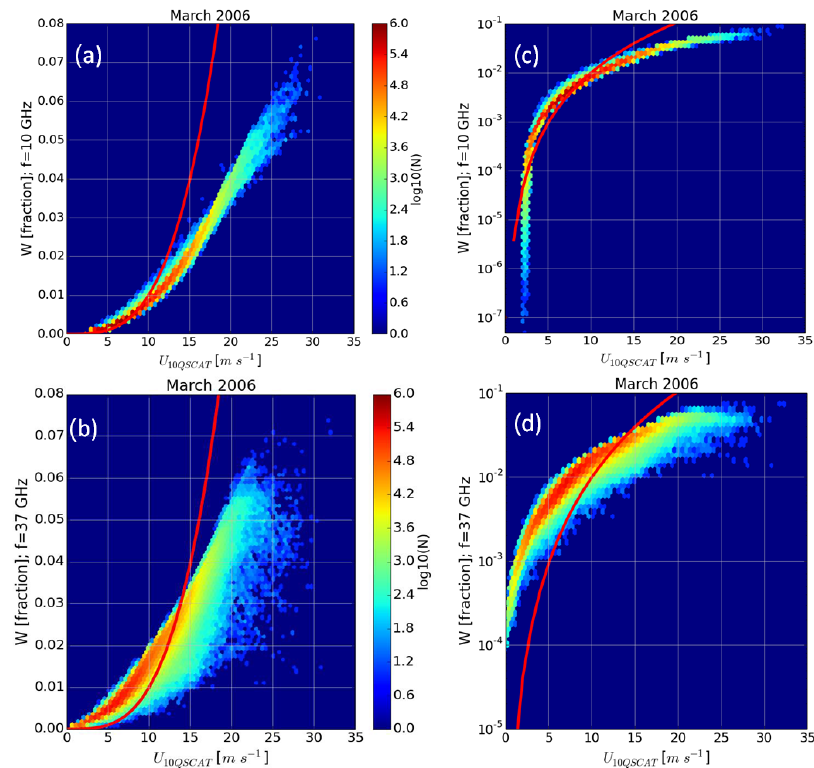
Figure 5. Global W as a function of U 10 from QuikSCAT for March 2006 where W is obtained with 10GHz (a) and 37GHz (b) mea- surement frequency. Panels (c) and (d) plot the data in (a) and (b) with logarithmic y axis. The red line indicates the Monahan and O’Muircheartaigh (1980, MOM80) relationship (Eq. 3). The colors indicate the amount of data points per hexbin.